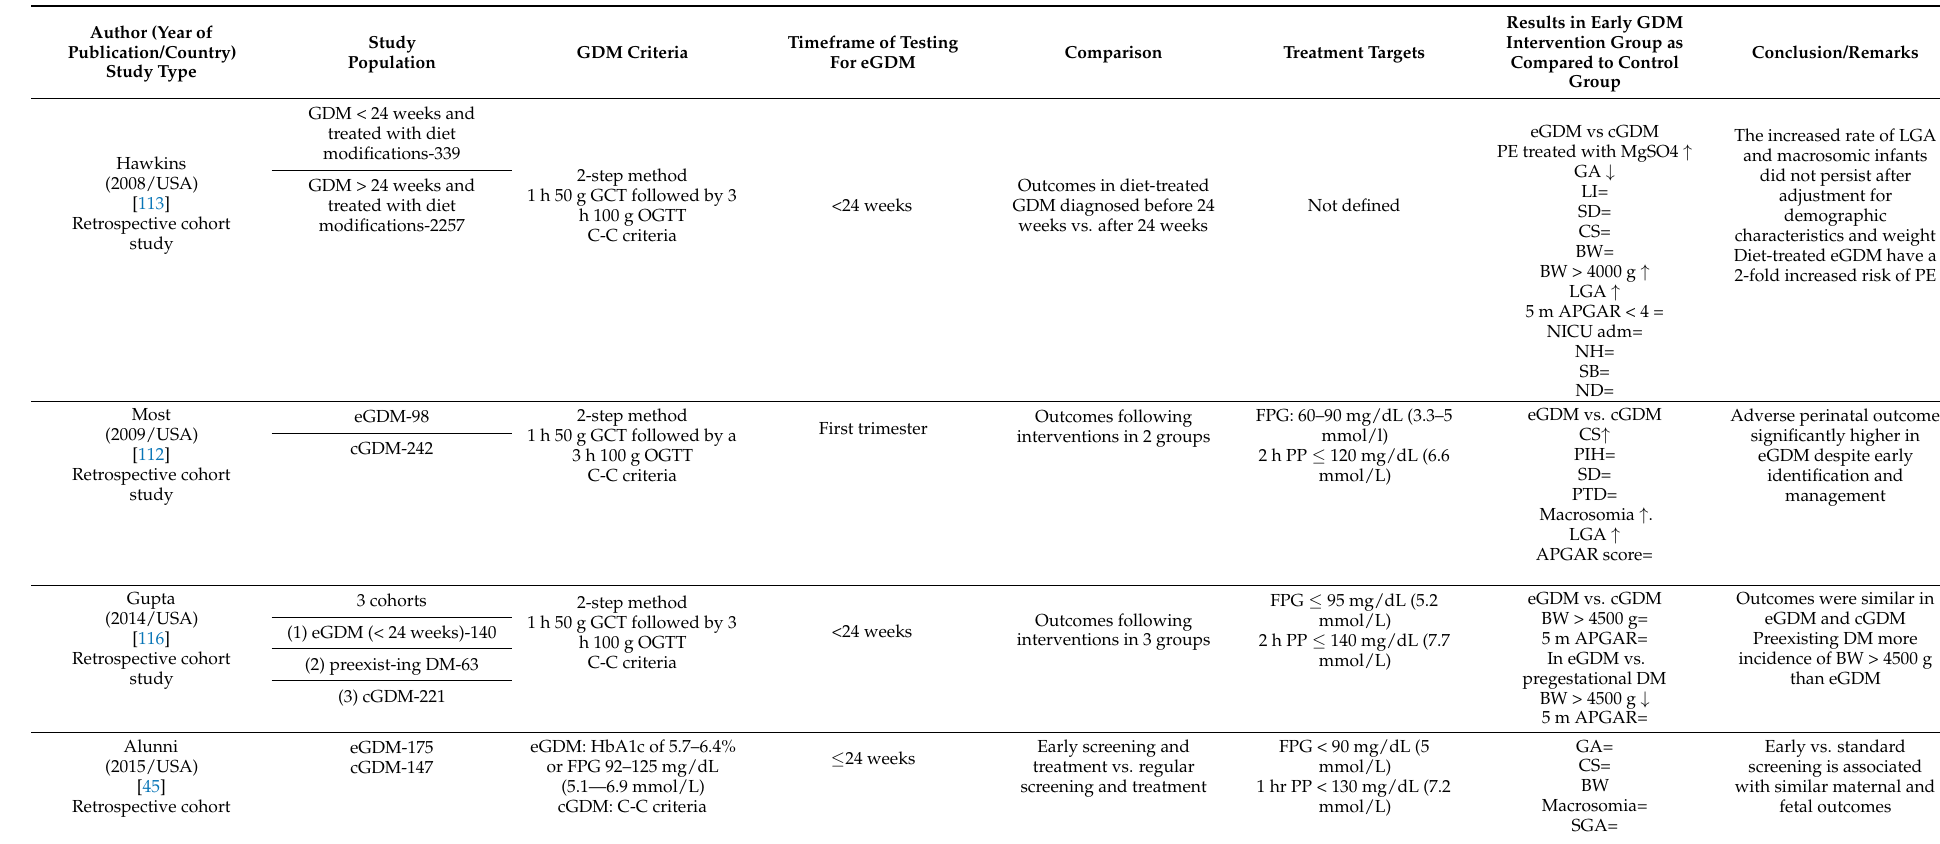
Table 5. Intervention studies in